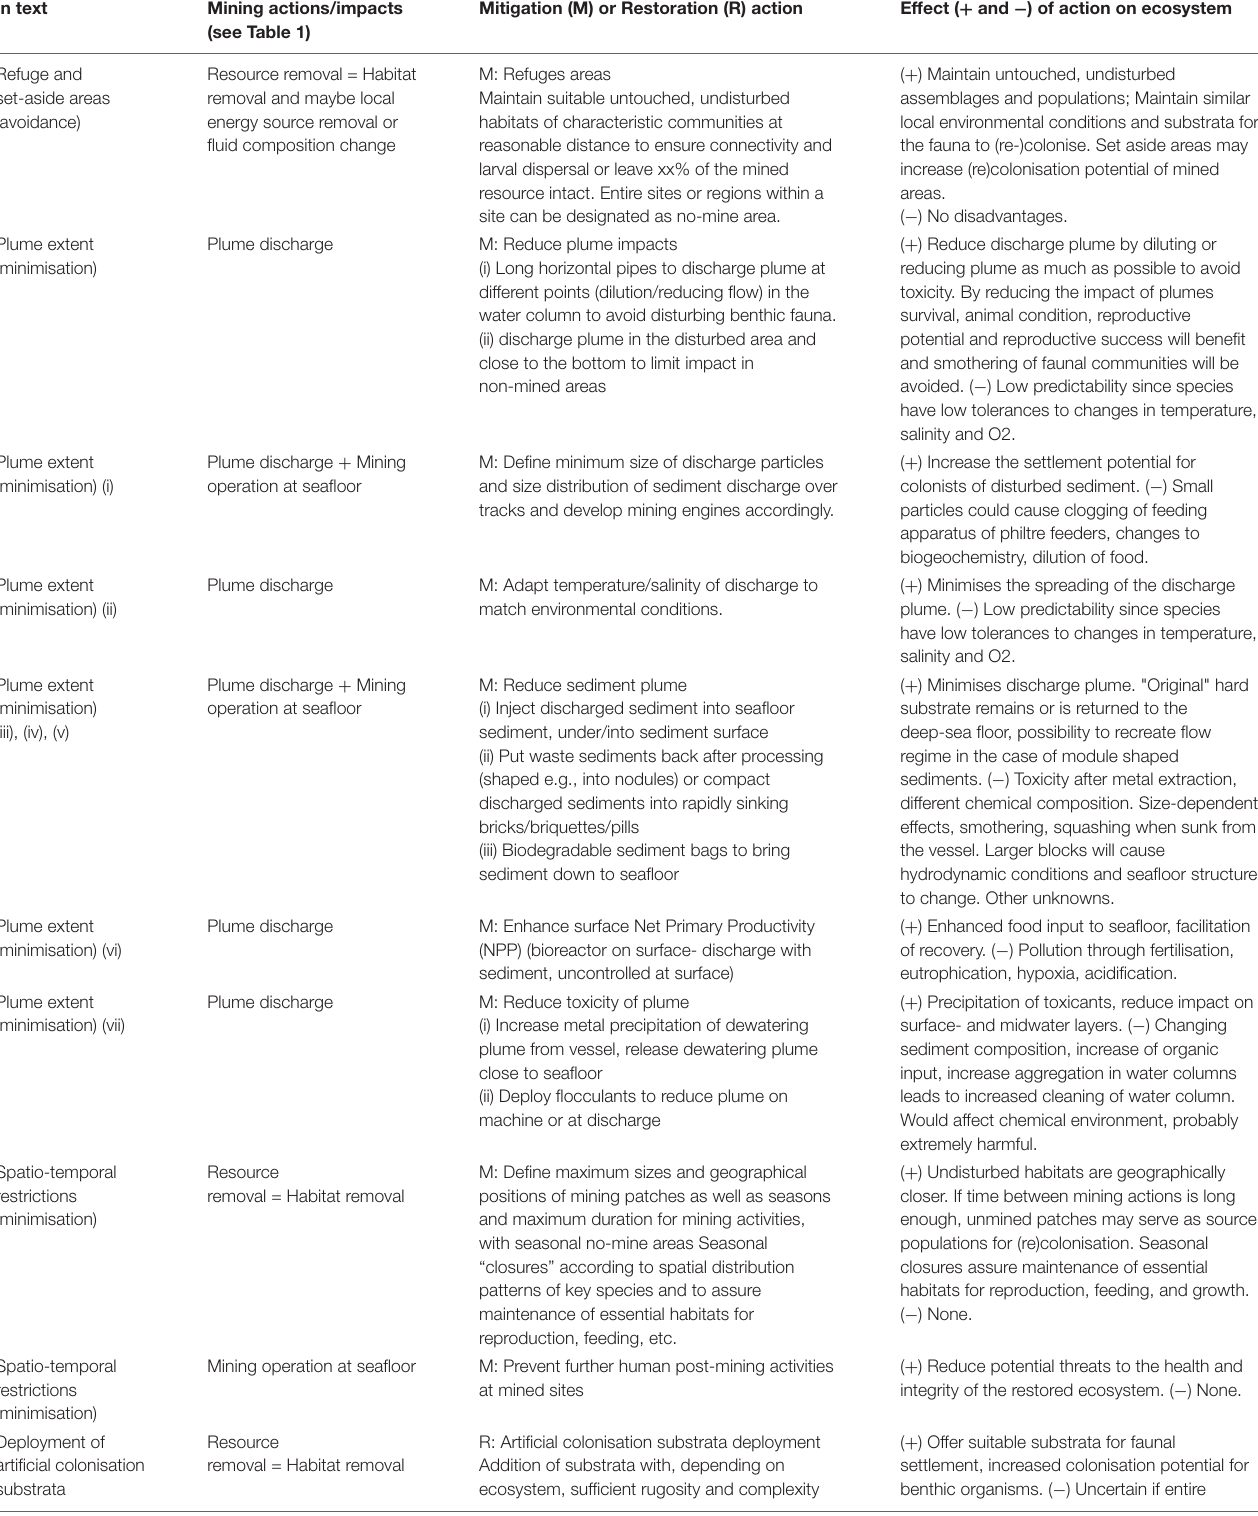
TABLE 2 | Recurrent mitigation and restoration actions across